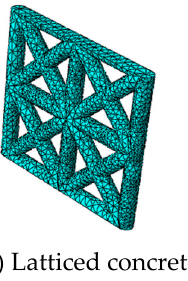
Figure 13. Finite element model of latticed concrete wall specimen with diagonal bracing.